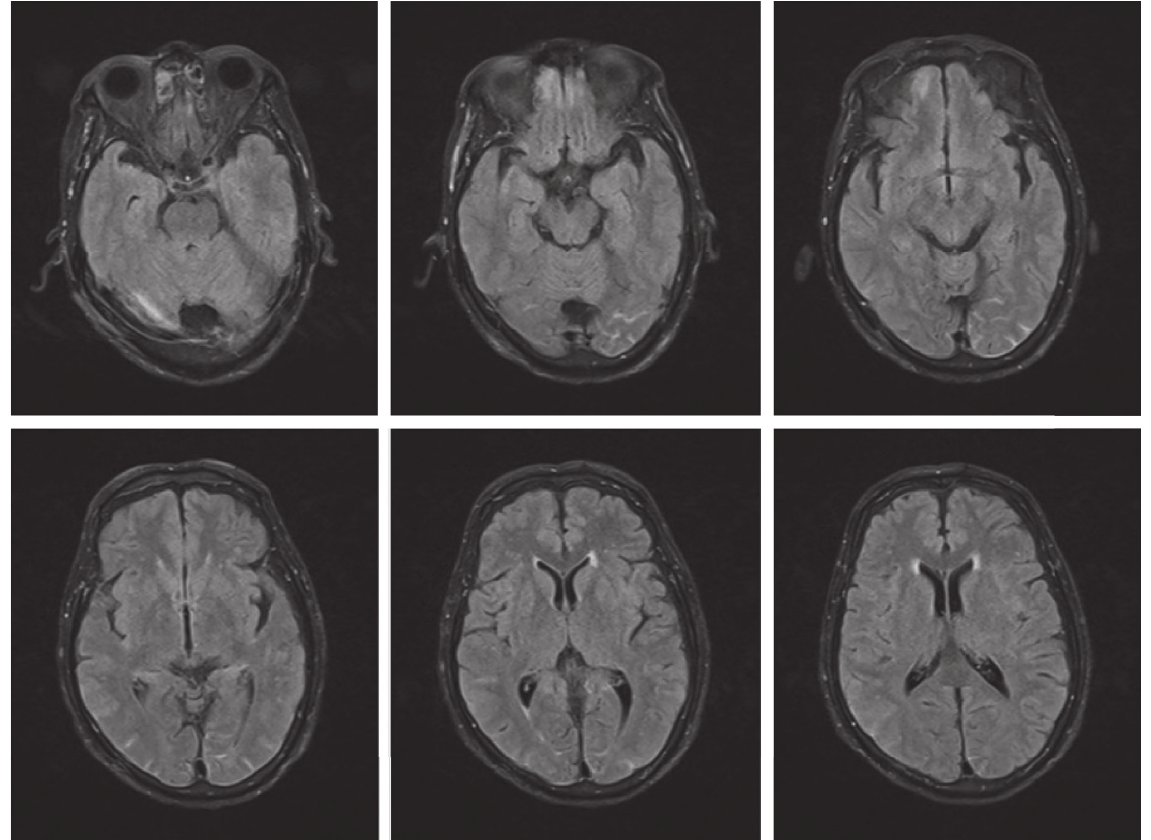
Figure 2: The MRI image in July 31st. A small amount of bleeding was displayed in the occipital